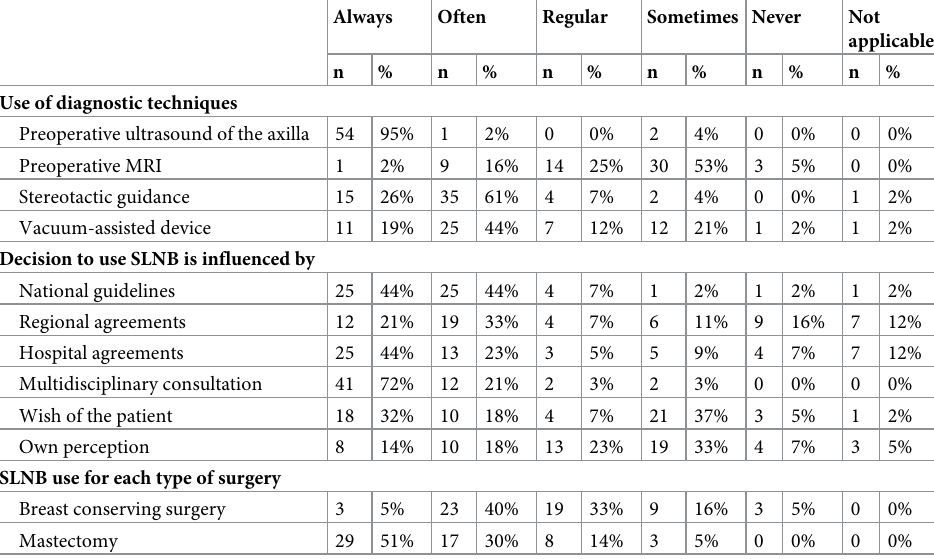
Table 4. Assessment of the organisational